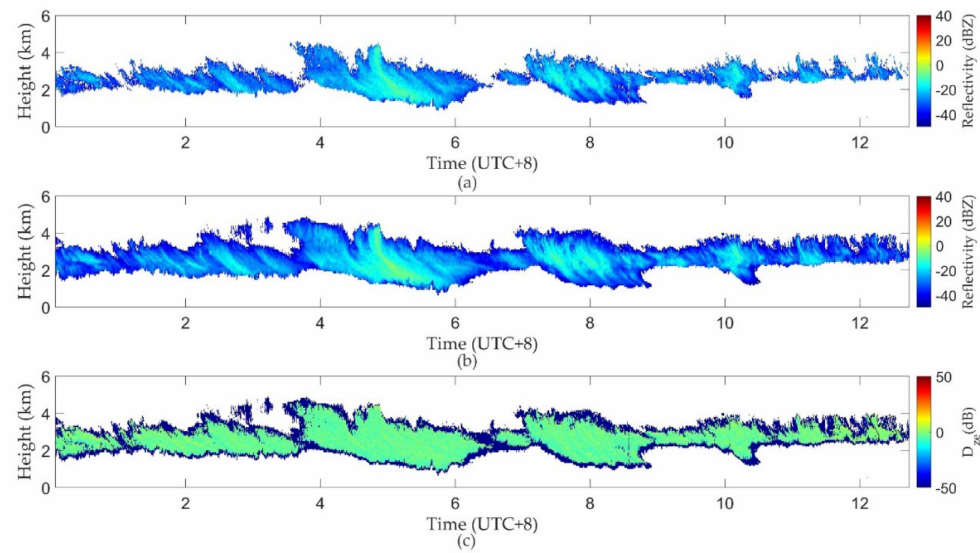
Figure 8. The reflectivity and its difference measured by the Ka-band radar and W-band radar on 3 March 2020: ( a ) Z e from the Ka-band radar; ( b ) Z e from the W-band radar; and ( c ) the D ze